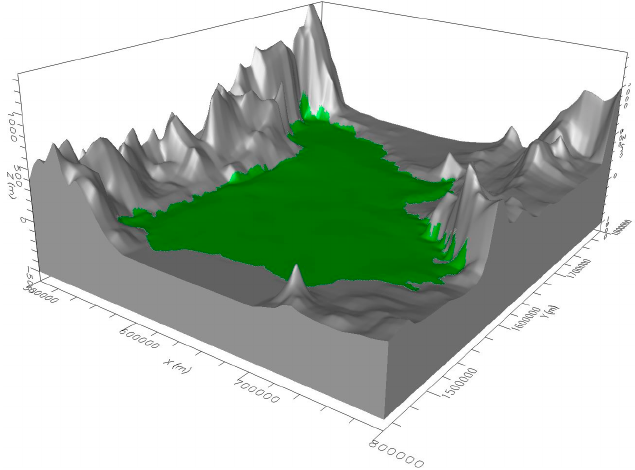
Figure 5. The 3D boundary and conceptual model of study area.